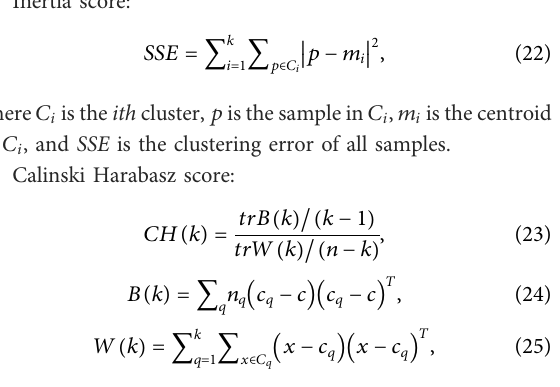
FIGURE 3 Classi fi cation model training